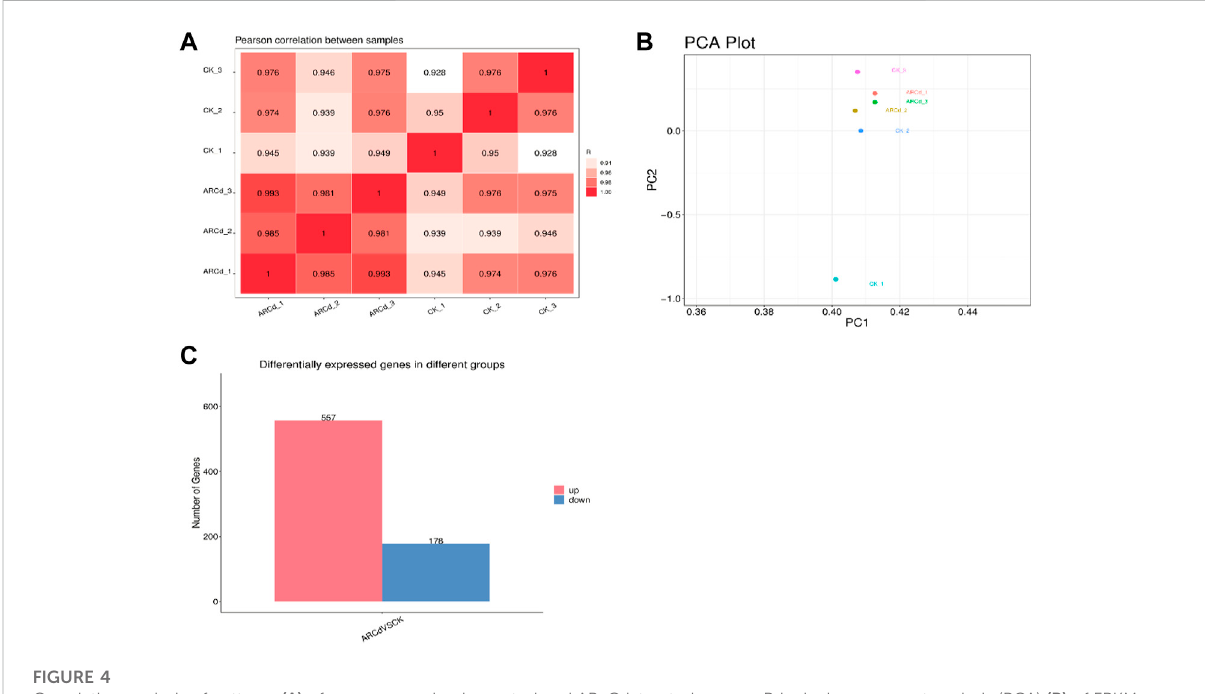
FIGURE 4 Correlation analysis of patterns (A) of gene expression in control and AR-Cd-treated groups. Principal component analysis (PCA) (B) of FPKM pro fi les in control and AR-Cd treated groups. (C) Number of differentially express genes (DEGs) in AR-Cd treated groups.